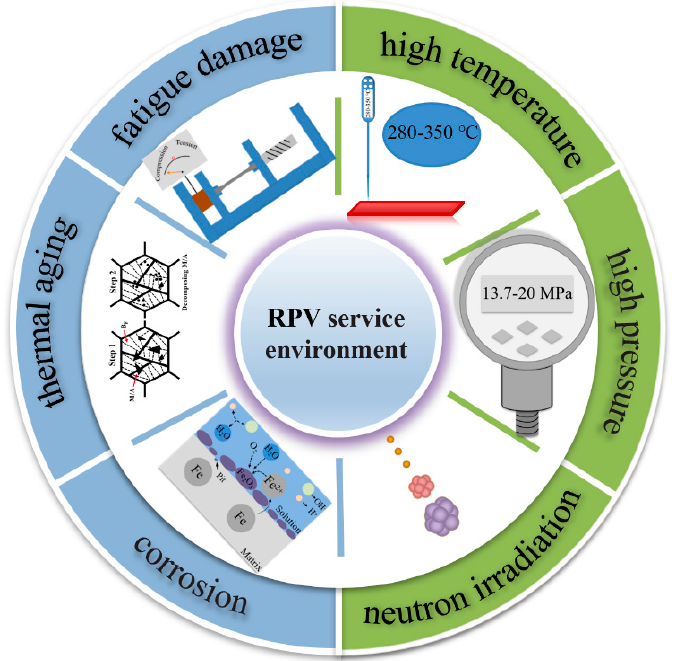
Figure 1. The service environment of nuclear pressure vessel